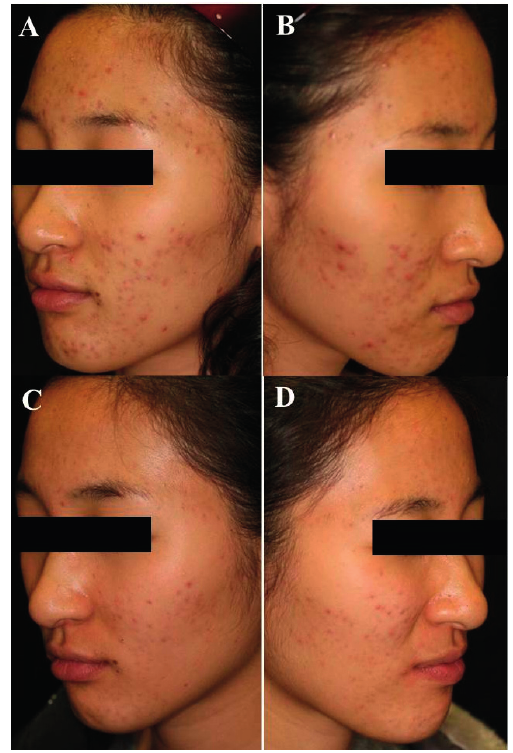
Figure 2. Representative photographs before ( A , B ) and after chlorophyll-PDT treatment ( C , D ). After three treatment sessions of chlorophyll-PDT, there was a significant decrease in the number of papules and pustules in moderate inflammatory acne patient